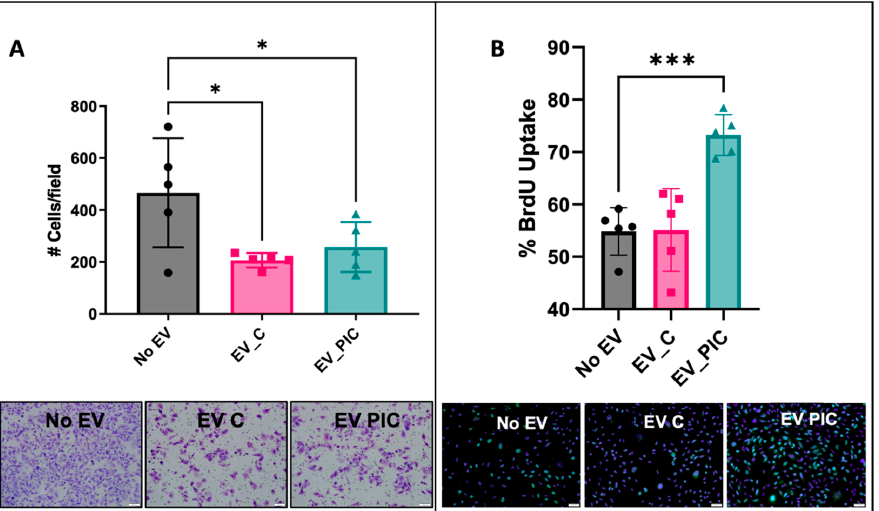
Figure 2. Effect of HAMVEC EV C and EV PIC on PC3ML invasion and proliferation. PC3MLs were incubated overnight with HAMVEC EV C or EV PIC, and invasion was assessed using Matrigel invasion chambers. PC3ML treated with HAMVEC EV C or EV PIC showed reduced invasion by 2.3- and 1.8-fold, respectively (EV C, n = 5,* p = 0.0147; EV PIC, n = 5, * p = 0.0405). Scale bar indicates 100 𝜇 m ( A ). Proliferation was assessed via fluorescent microscopy evaluation of BrdU incorporation. HAMVE EV PIC but not EV C increased proliferation by 1.3-fold ( n = 5, *** p = 0.0005). Scale bar indicates 50 𝜇 m ( B ).